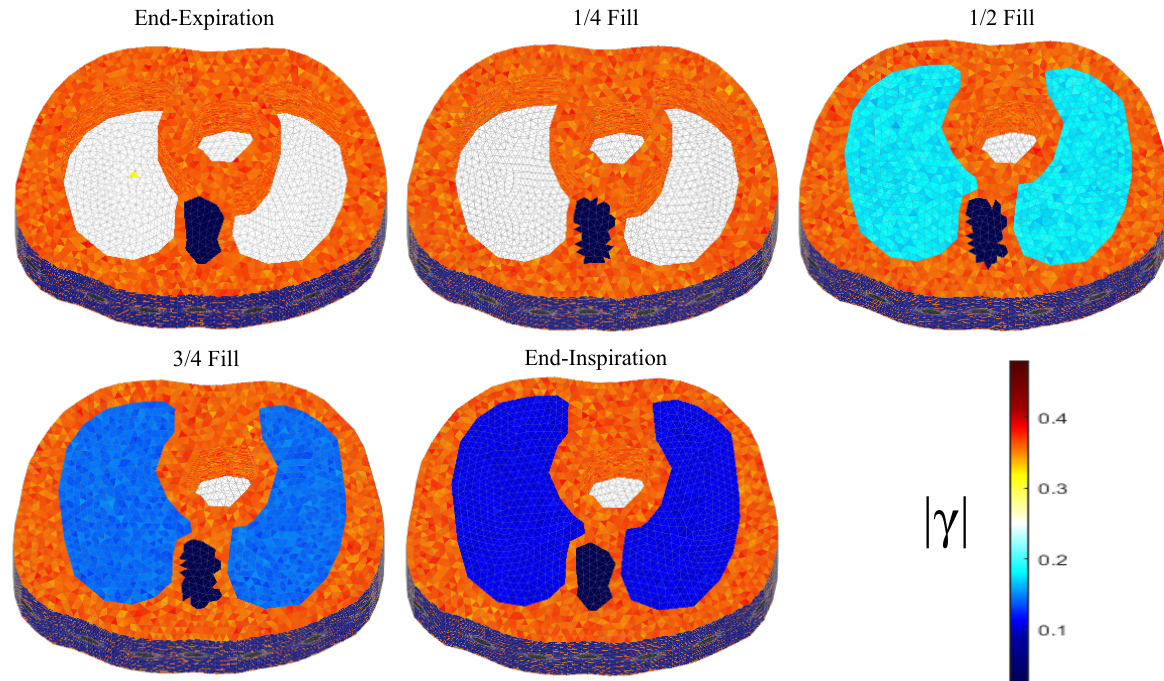
Figure 2. The 3D F.E. structure for the 1st subject case in 5 breath cycle